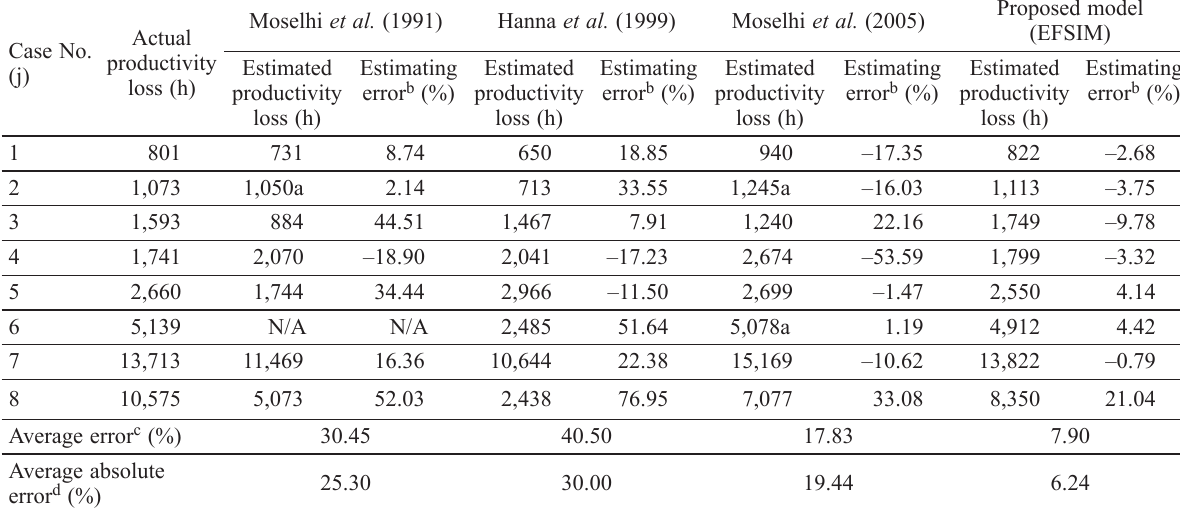
Table 7. Actual versus estimated productivity loss (Moselhi et al . 2005)